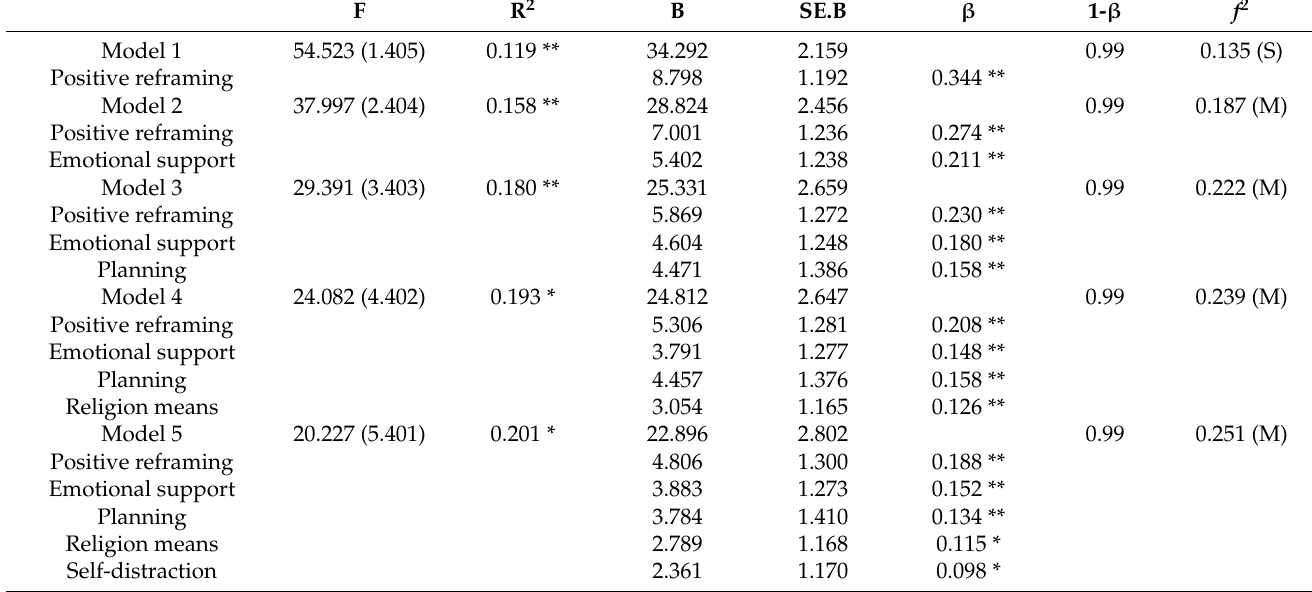
Table note: M = medium effect size, S = small effect size. Significance value * p < 0.05, ** p < 0.001.